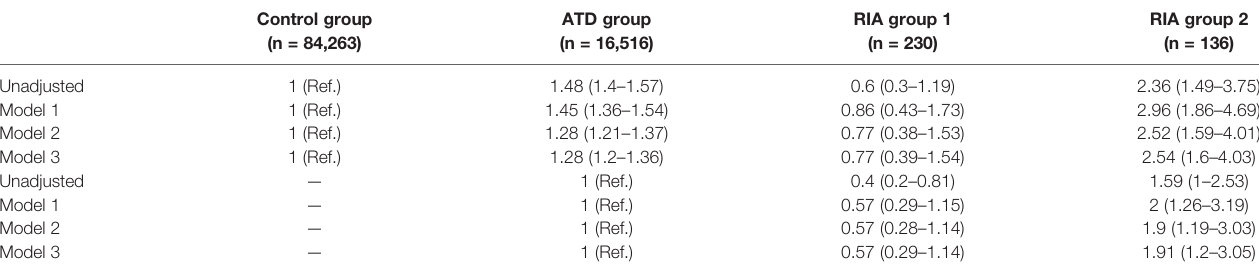
TABLE 3 | Hazard ratios and 95% con fi dence intervals for heart failure among treatment groups; ATD vs. RIA with remission vs. RIA without remission. Control group ATD